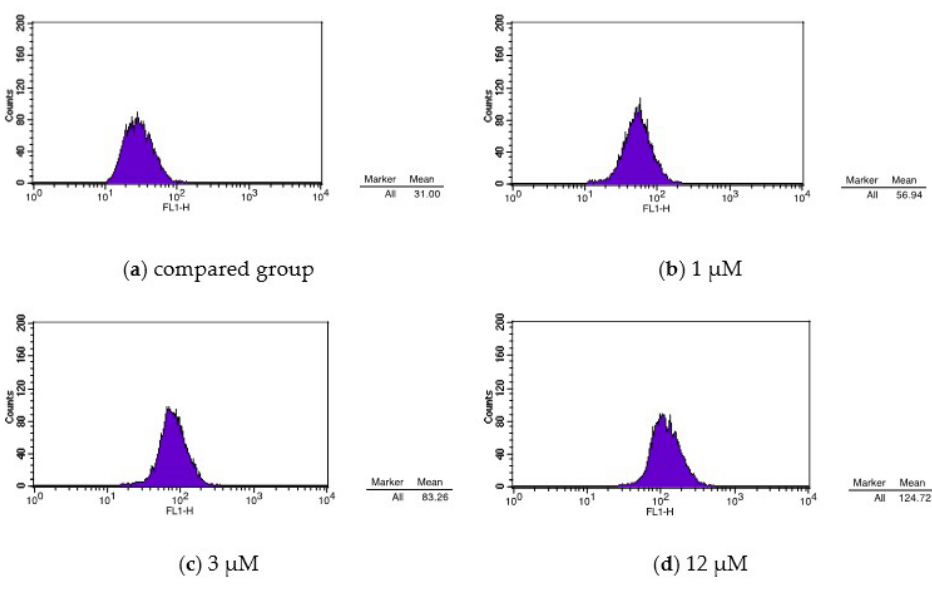
Figure 8. Different concentration of compound 4 of ( a ) compared group, ( b ) 1 µM, ( c ) 3 µM and ( d )